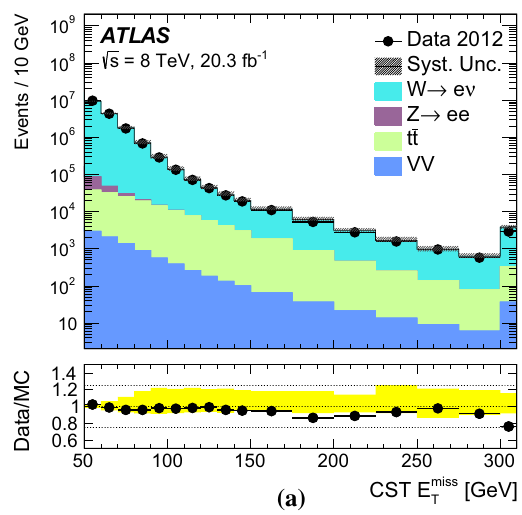
as measured in a combined systematic and MC statistical uncertainties. The far right bin T includes the integral of all events with E miss